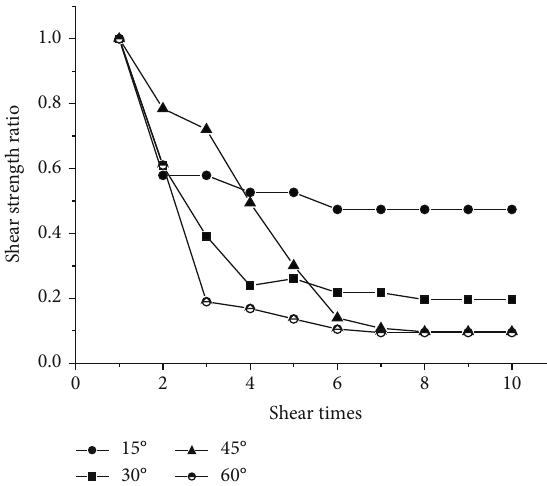
Figure 5: Relationship between shear strength ratio and shear times.